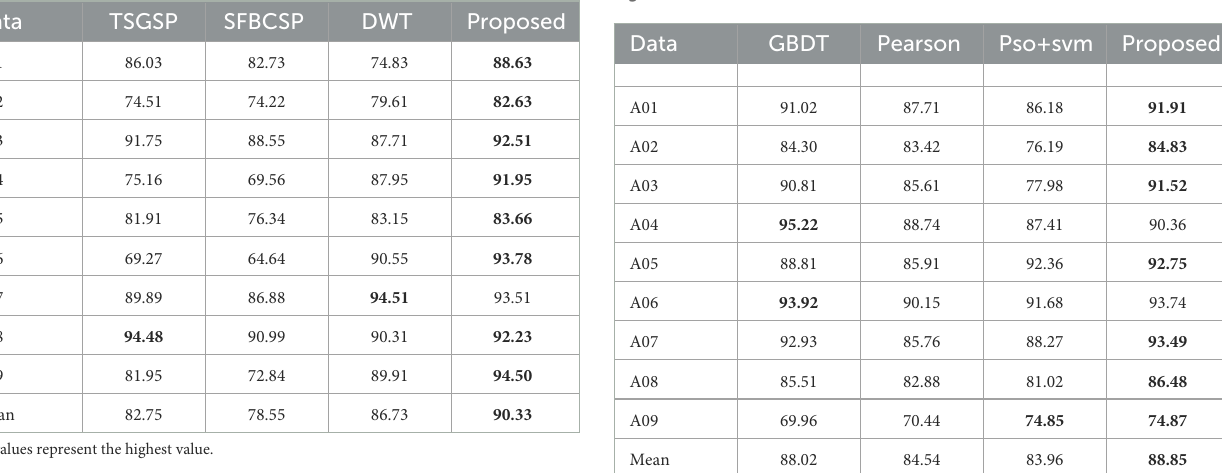
TABLE 7 The classification accuracy for different feature selection algorithms on dataset IIIa. Data